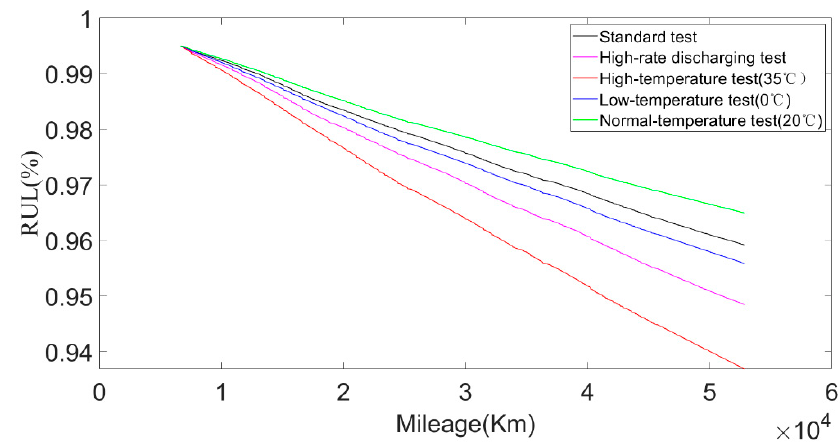
Figure 25. RUL calculation results of battery under different test environments.